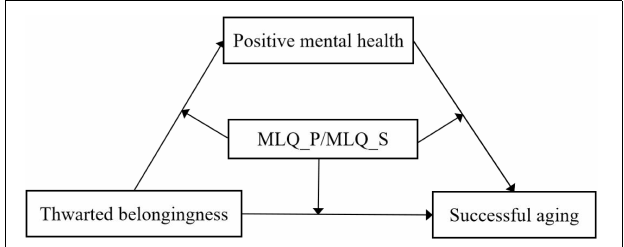
FIGURE 1 | The moderation mediation model showing the relationships among thwarted belongingness, positive mental health, meaning in life, and successful aging. MLQ_P, presence of meaning; MLQ_S, search for meaning.